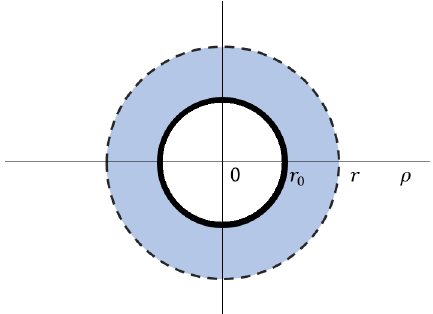
Figure 1. Goubau line; a single wire conductor coated with dielectric